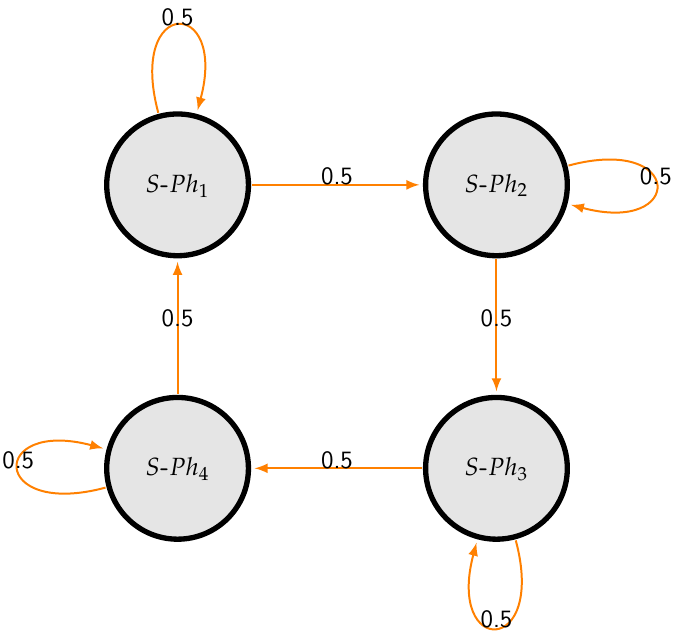
Figure 4. Evolutionary states defined for the Adaptive PSO algorithm: S - Ph { 1,2,3,4 } represent Explo- ration, Exploitation, Convergence, and Jump-out,